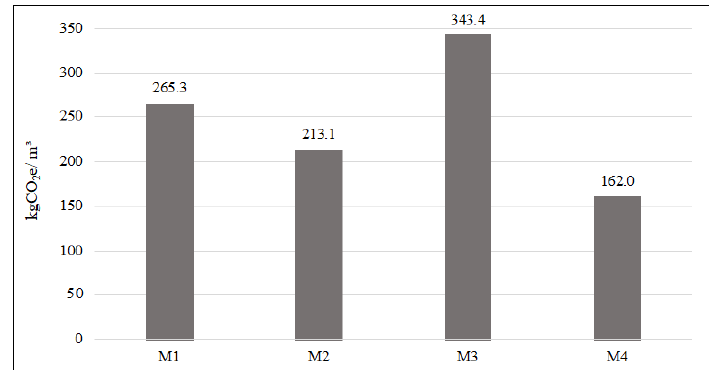
Figure 6. kgCO 2 e/ m 3 .